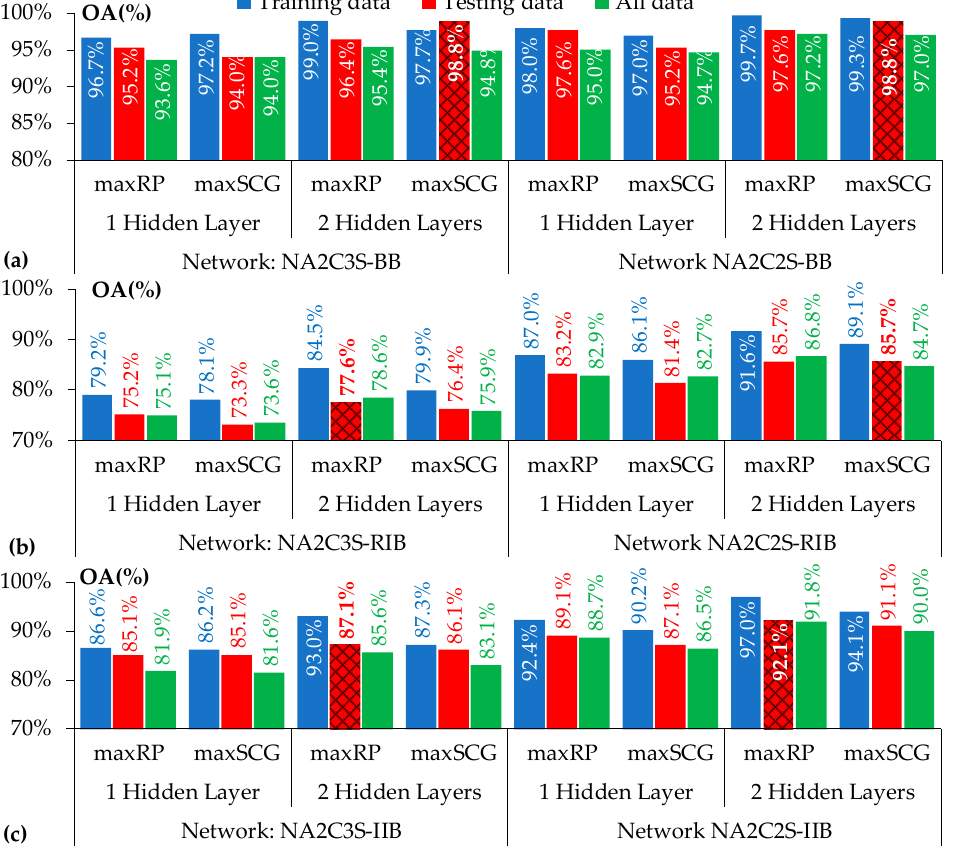
Figure 9. Maximum OA index values extracted by NA2C3S and NA2C2S networks with 1 or 2 hidden layers: ( a ) BB; ( b ) RIB; ( c ) IIB.